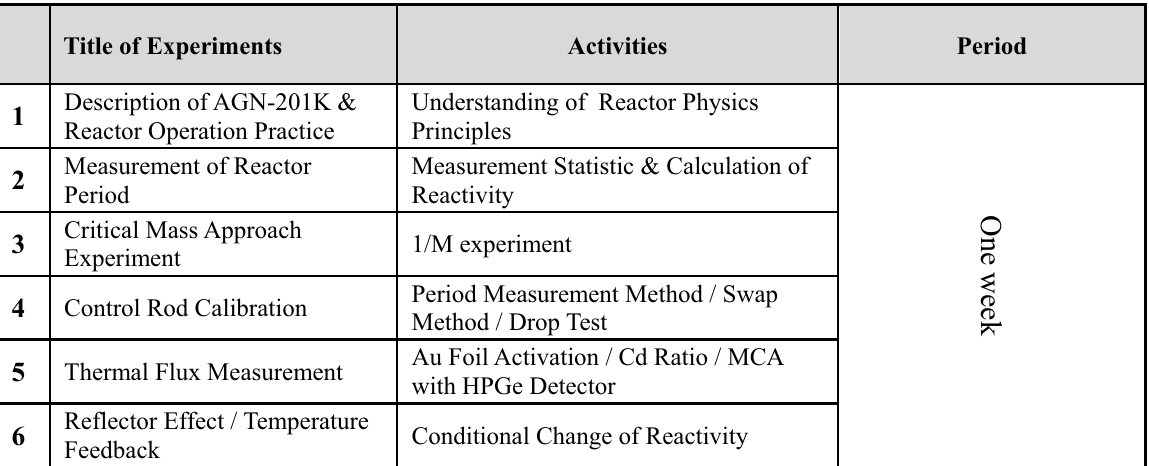
Table III. Reactor physics experimental training course using the AGN